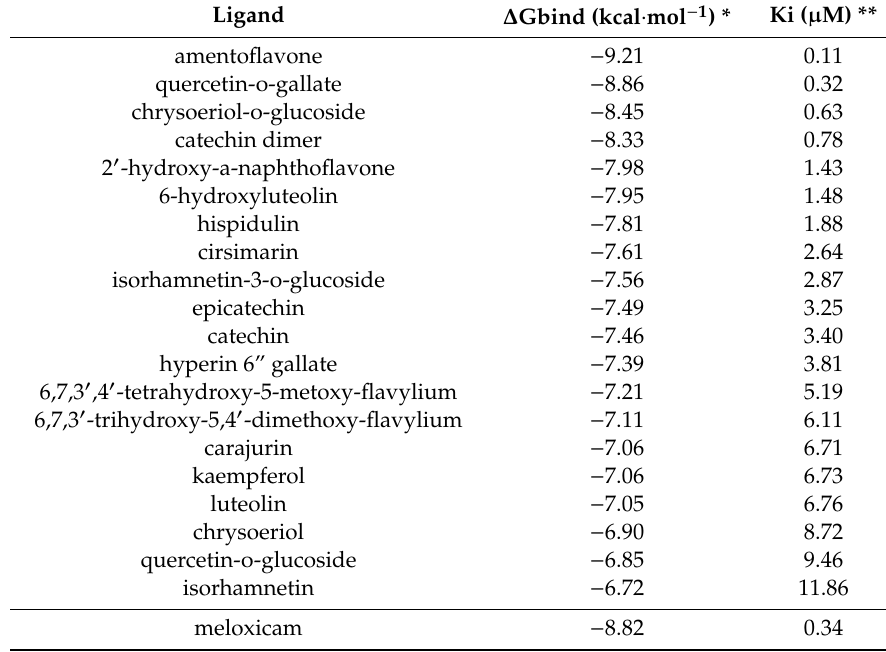
Table 2. Free-binding energies and inhibition constant obtained by molecular docking of the compounds identified in the A. chica extract with the COX-2 structure.